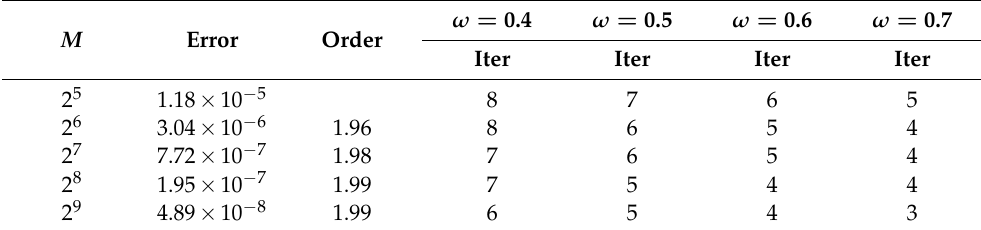
Table 1. L 2 errors for (72) with different ω by the second-order scheme. M